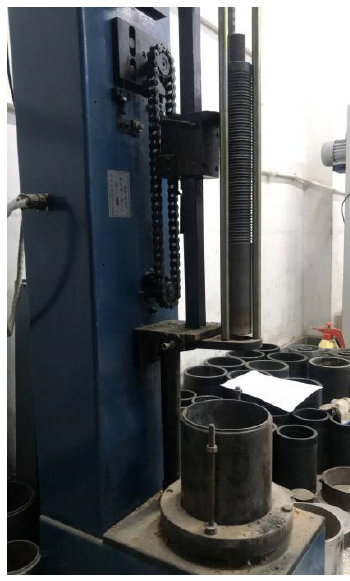
( b ) Experimental instruments Figure 8. Unconfined compressive strength test. 3.4. Splitting Tensile Strength Test According to JTG E51-2009 “Test methods of materials stabilized with inorganic binders for highway engineering” [36], the splitting tensile test was carried out on cement